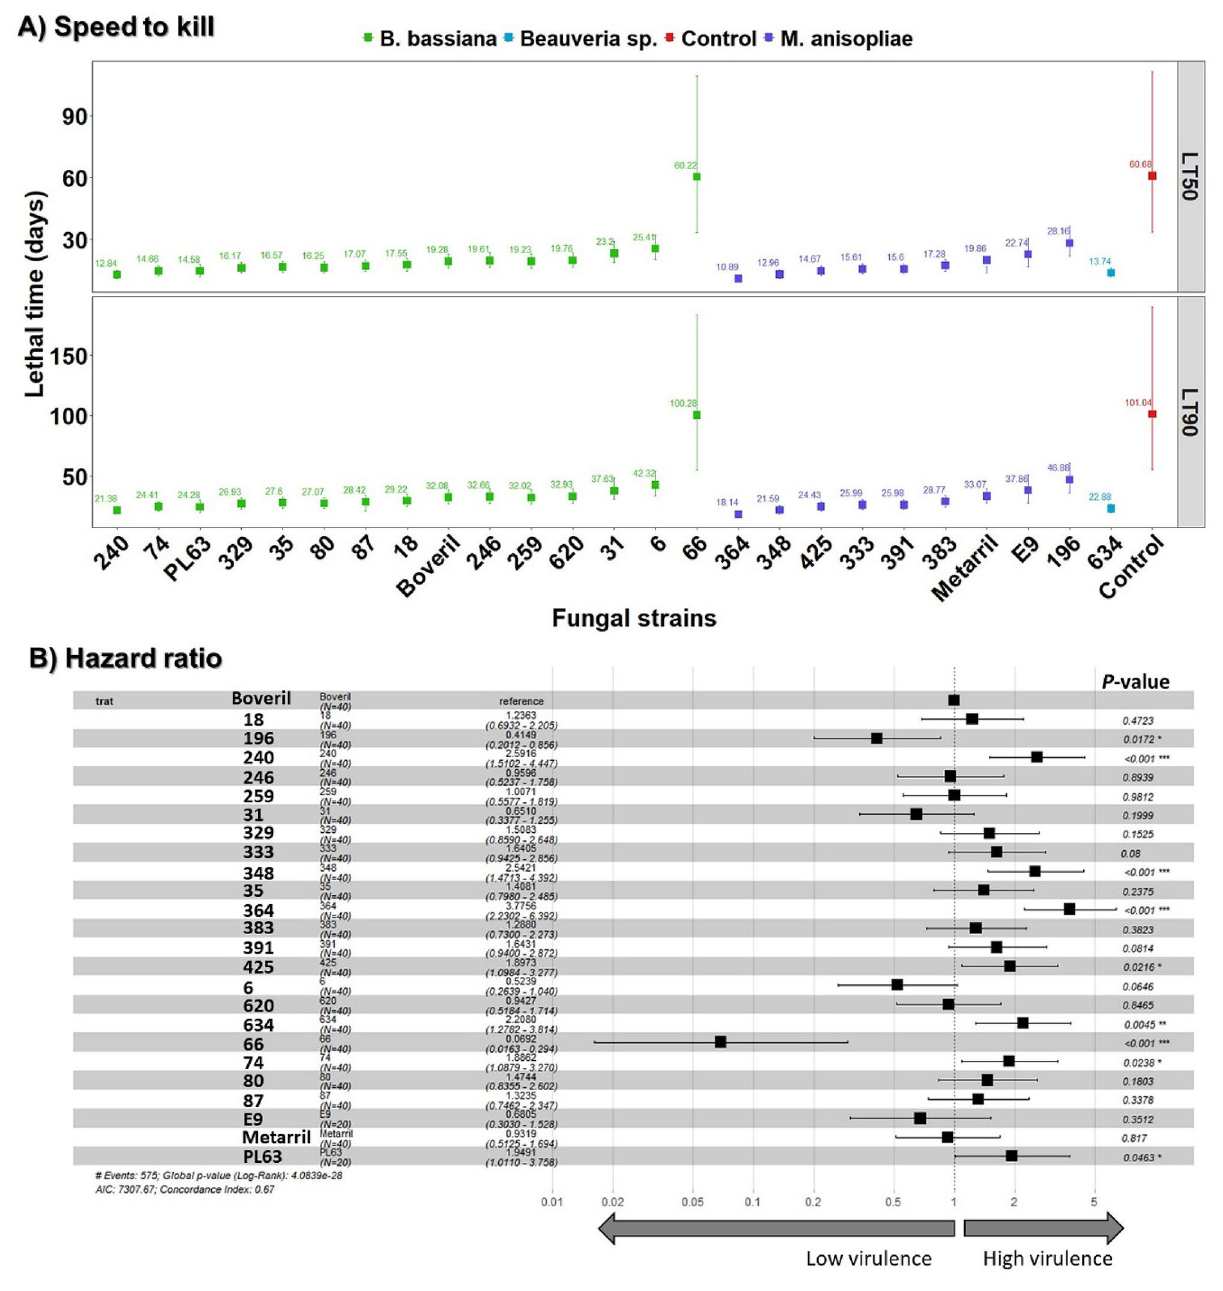
Figure 2. Susceptibility of G. platensis adults after exposure to several strains of M. anisopliae and B. bassiana applied with a single concentration of 1 × 10 8 conidia mL −1 . ( A ) Speed to kill represented by 50% and 90% lethal times (LT 50 /LT 90 , in days) estimated with Weibull models fitted to survival censored data of several fungal strains. Lethal times are significantly different when their 95% confidence intervals (whiskers) do not overlap. ( B ) Hazard ratios (square symbols) for fungal infection compared to the commercial mycoinsecticide Boveril, which is assigned as the reference group and currently registered to control Gonipterus spp. in Brazil. Significant P -values are indicated by asterisks (*< 0.05, **< 0.01 or ***< 0.001) and represent the strains that were significantly different (more/less virulent) from the reference Boveril. Whiskers represent the 95%